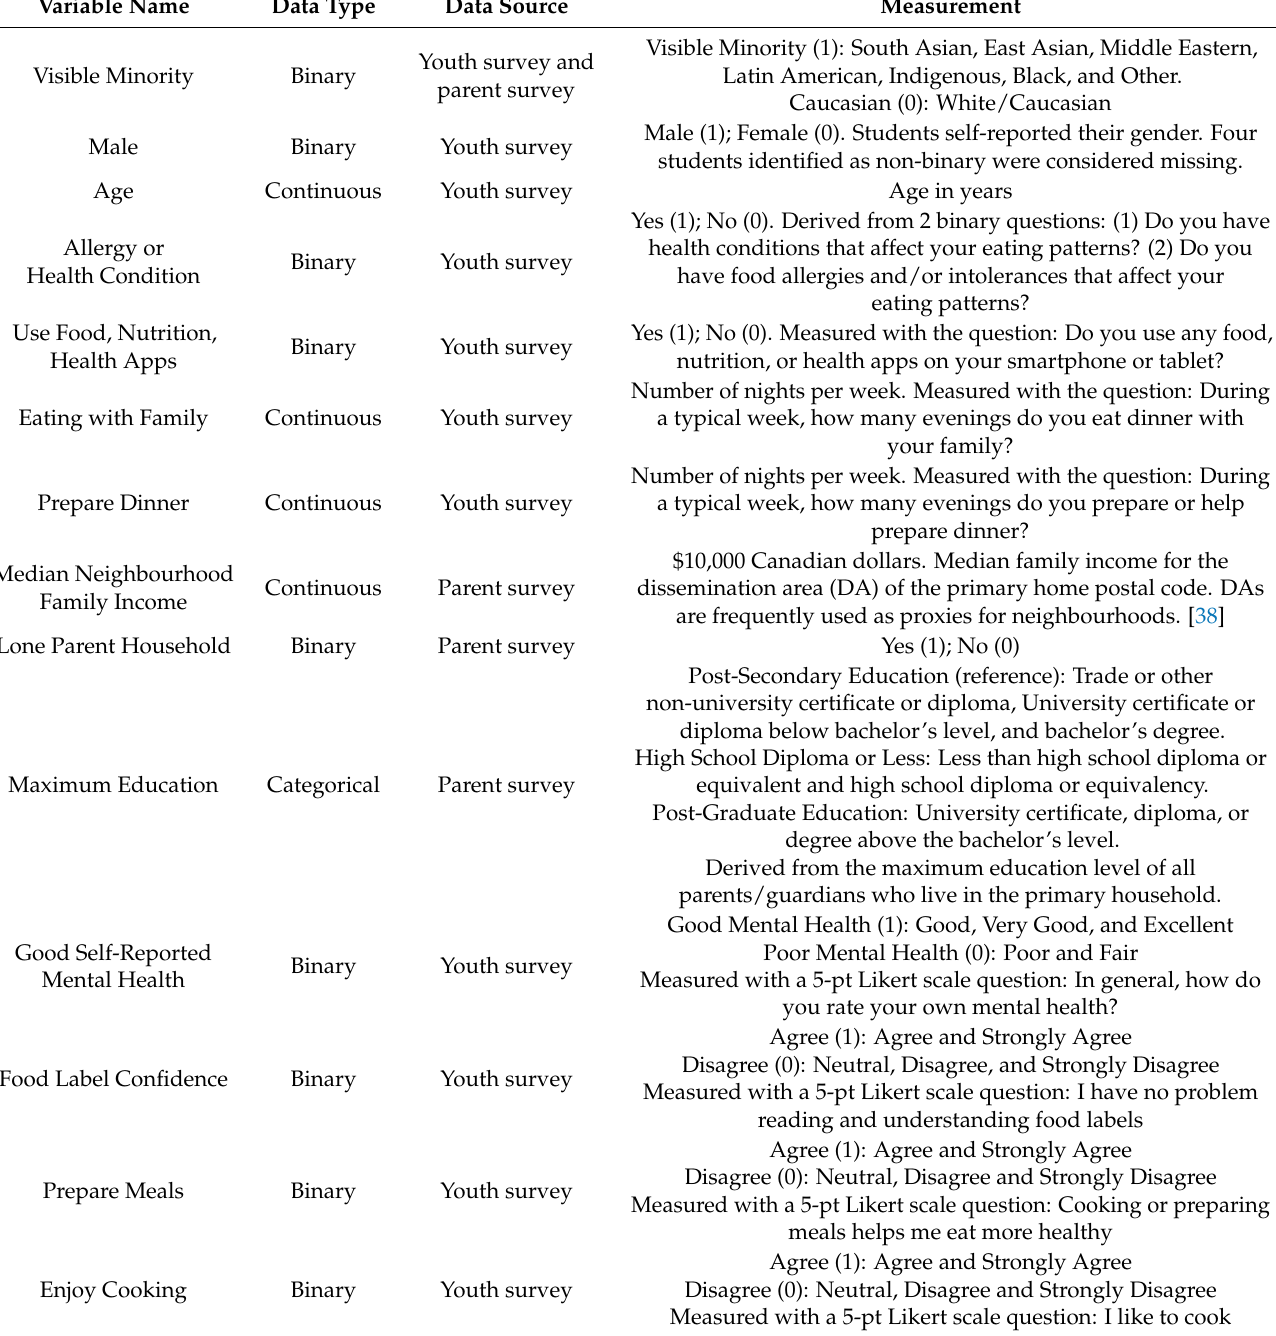
Table 2. Definition of Independent